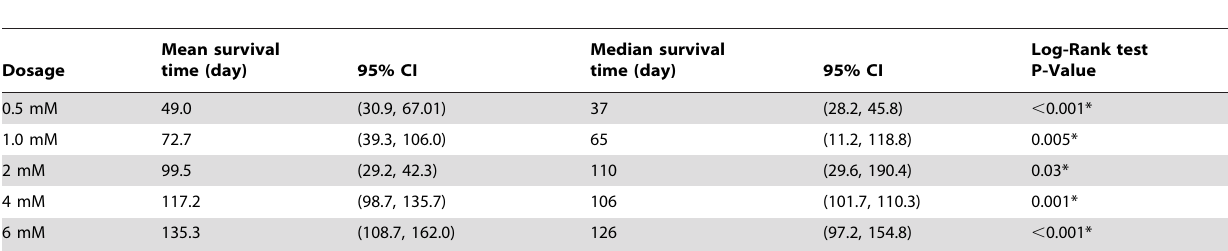
Table 3. Comparison of the mean and median survival time between the mice injected with different dosages of PMO(-10-34) or